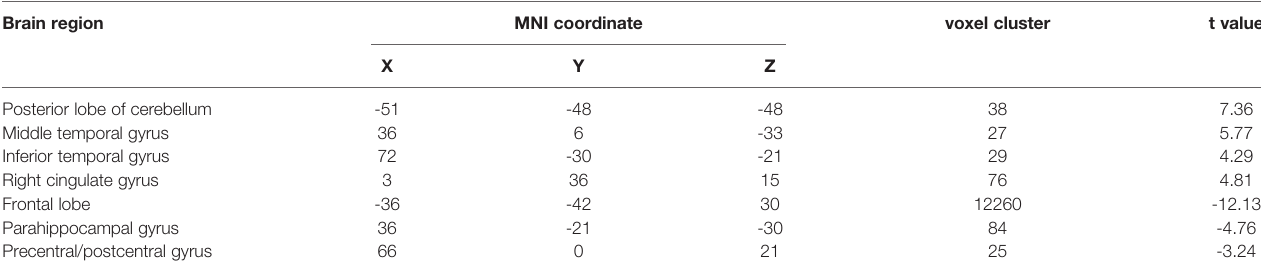
TABLE 3 | The abnormal brain regions and functional connectivity found in the left frontoparietal network in ATM and nATM groups. Brain region MNI coordinate voxel cluster t value X Y Z Posterior lobe of cerebellum